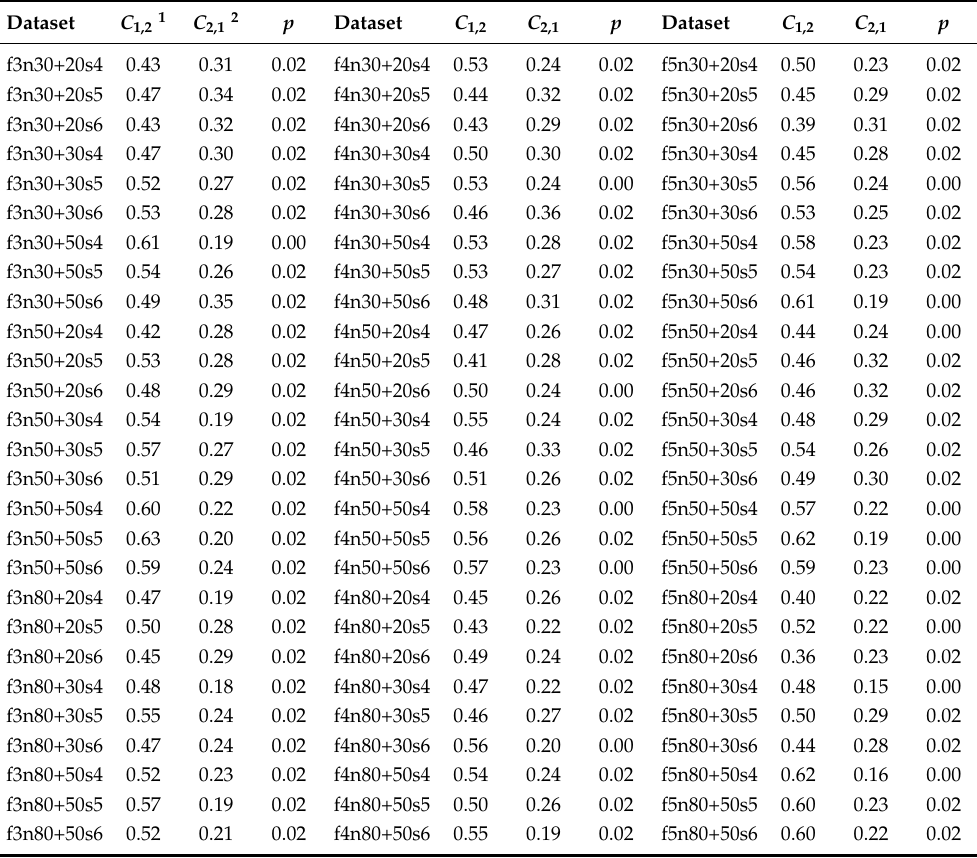
Figure 5. Boxplots of C Metric of KCDE, KCDE-Ran, KCDE-nKB and KCDE-nLI; ( a ) Boxplots of KCDE and KCDE-Ran; ( b ) Boxplots of KCDE and KCDE-nKB; ( c ) Boxplots of KCDE and KCDE-nLI. Table 4. Average C Metric Values of KCDE and